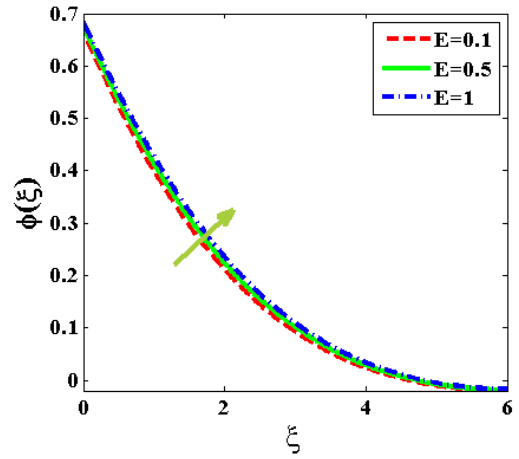
Figure 18. Outlines of 𝜙 at diverse quantities of 𝐸 .